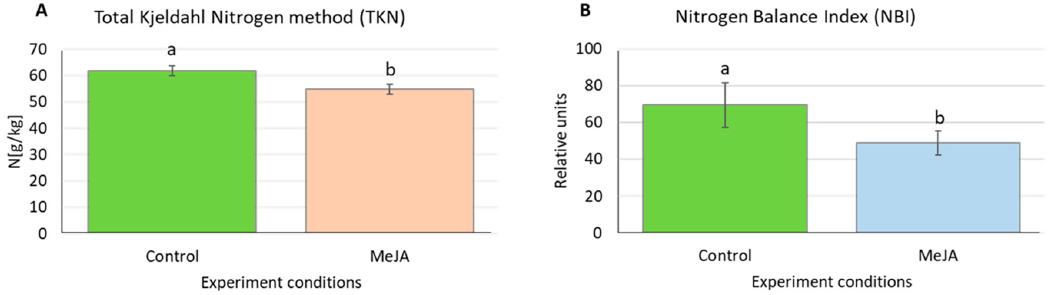
Figure 6. Nitrogen content in barley leaves after treatment with 500 µ M MeJA for five days measured using: ( A ) Total Kjedahl Nitrogen method (TKN); and ( B ) Nitrogen Balance Index (NBI). Data are presented as the means ± SD for three biological replications, 0.5 g leaf tissue and 10 seedlings per replication in the Kjedahl and NBI method, respectively. Statistically significant di ff erences